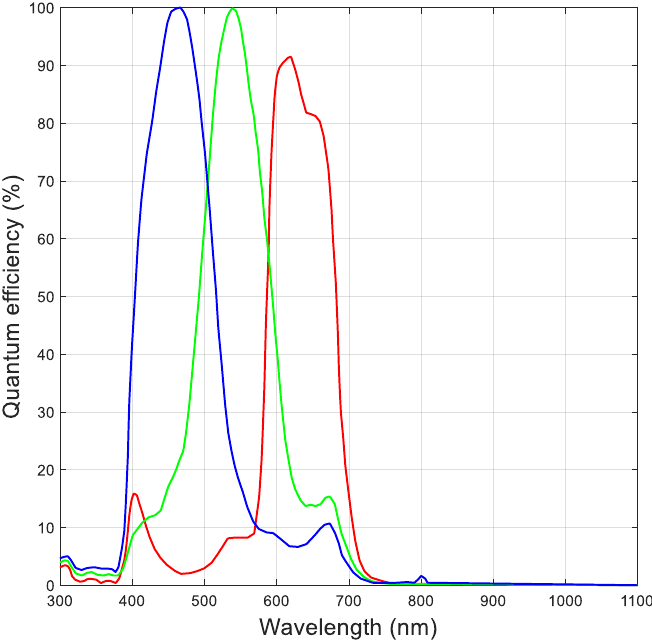
Figure 5. Normalized Spectral Response of BFLY-PGE-20E4C-CS Point Grey Camera for RGB channels. (From Point Gray Imaging Performance Specification v7.0).